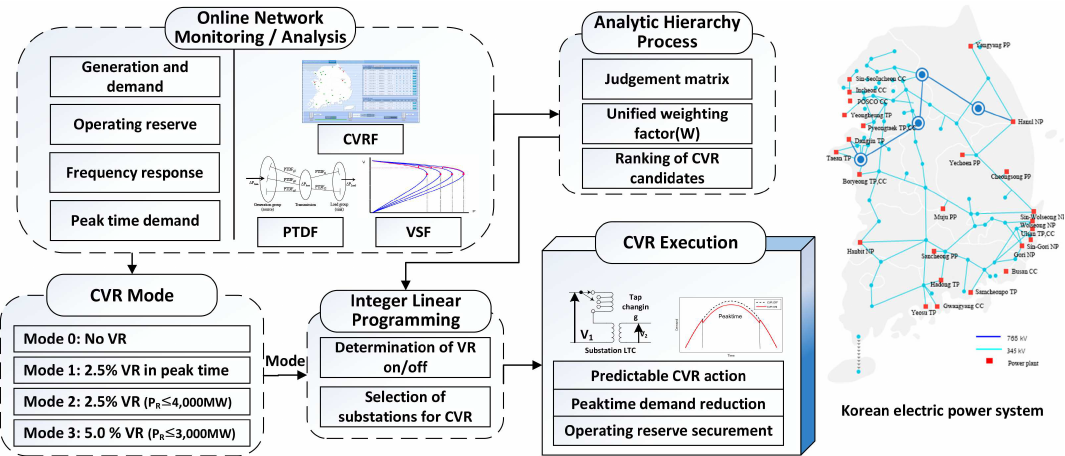
Figure 1. A proposed framework for the Korean electric power